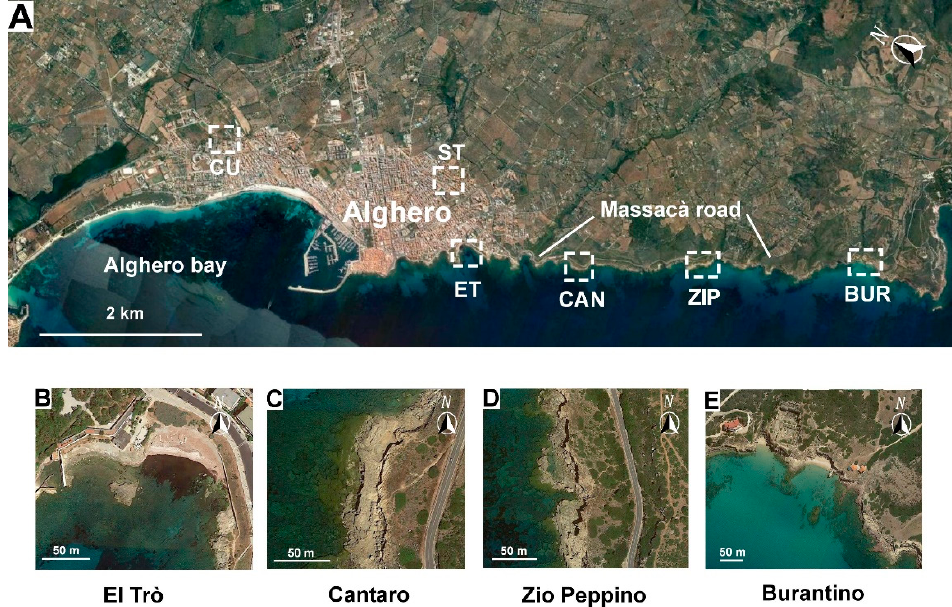
Figure 1. Sardinia. ( A ) Satellite view of the Mediterranean region where Sardinia occupies a central position. Dashed line indicates the Sardinia anticlockwise rotation of the island occurred that in the Neogene time; ( B ) Digital terrain model of Sardinia; in the map are reported the main cities. Alghero is on the north-west coast. BI = Balearic Islands; lp = Liguro–Provençal Basin; Ty = Tyrrhenian Sea.